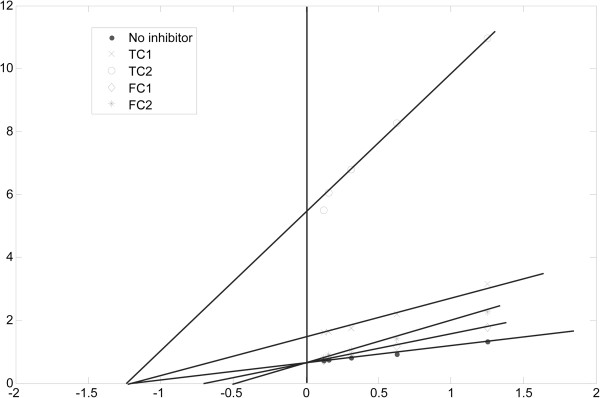
Lineweaver-Burk plot for the inhibition mode of flavonoid compound (FC) and triterpenoid compound (TC) against α-glucosidase. No inhibitor: absence of sample as a control; TC1: 8ug/mL; TC2: 16ug/mL; FC1: 8ug/mL; FC2: 16ug/mL.